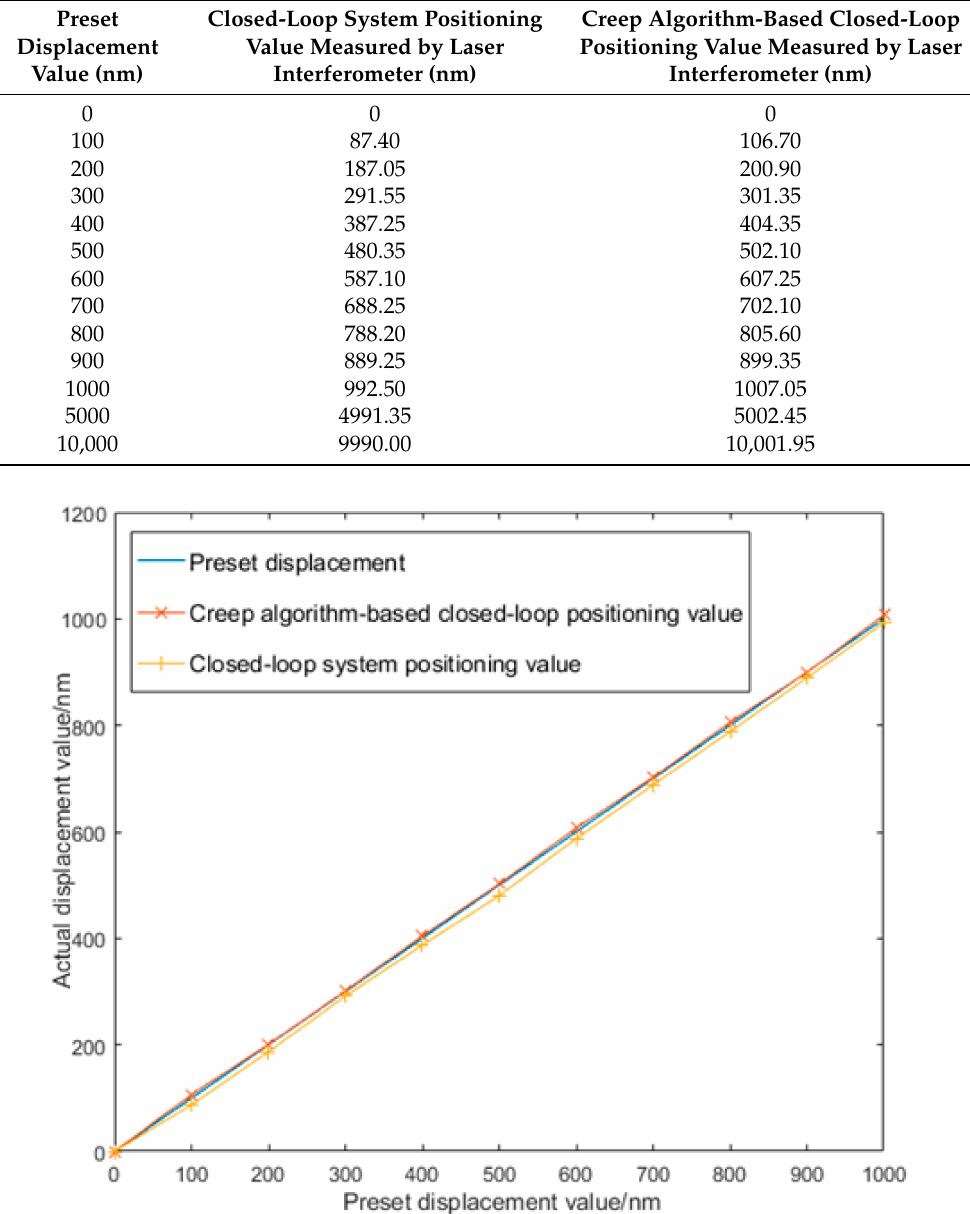
Table 3. The measured data of the preset displacement.